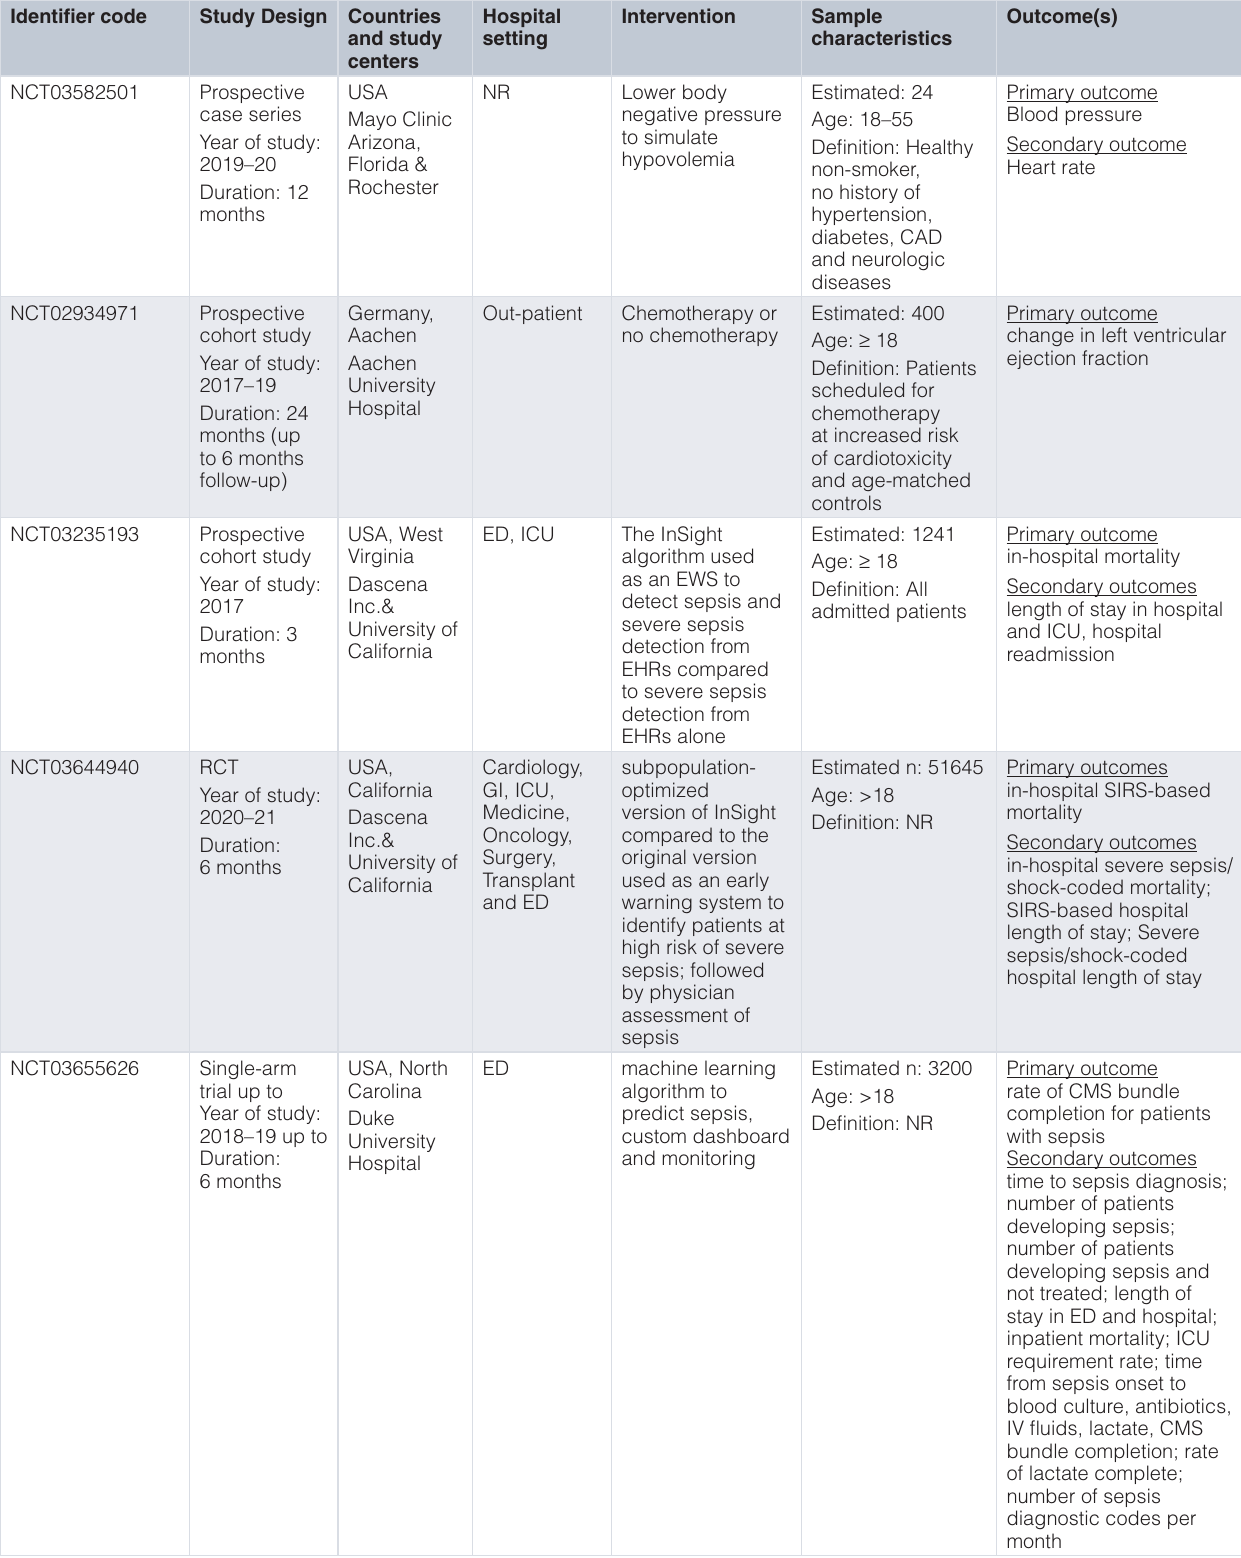
Table 5. Overview of ongoing studies on shock. Identifier